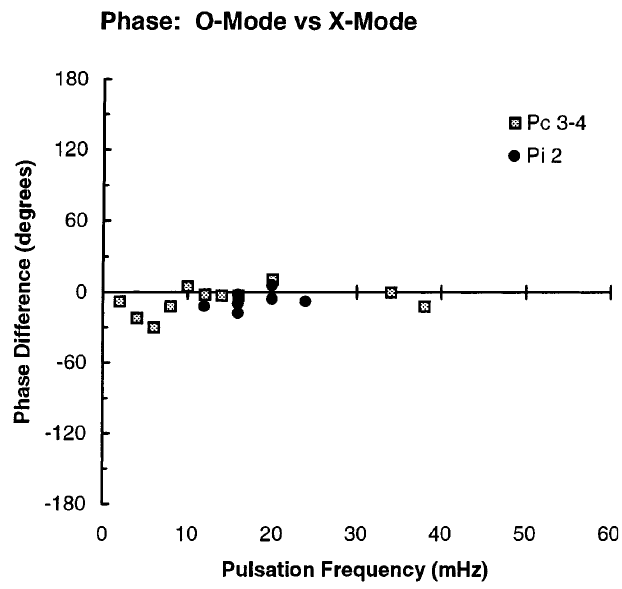
Fig. 10. Phase di(cid:128)erence between 5.00 MHz O- and X-mode Doppler shifts. Squares denote day-time Pc 3-4 events , solid circles night-time Pi